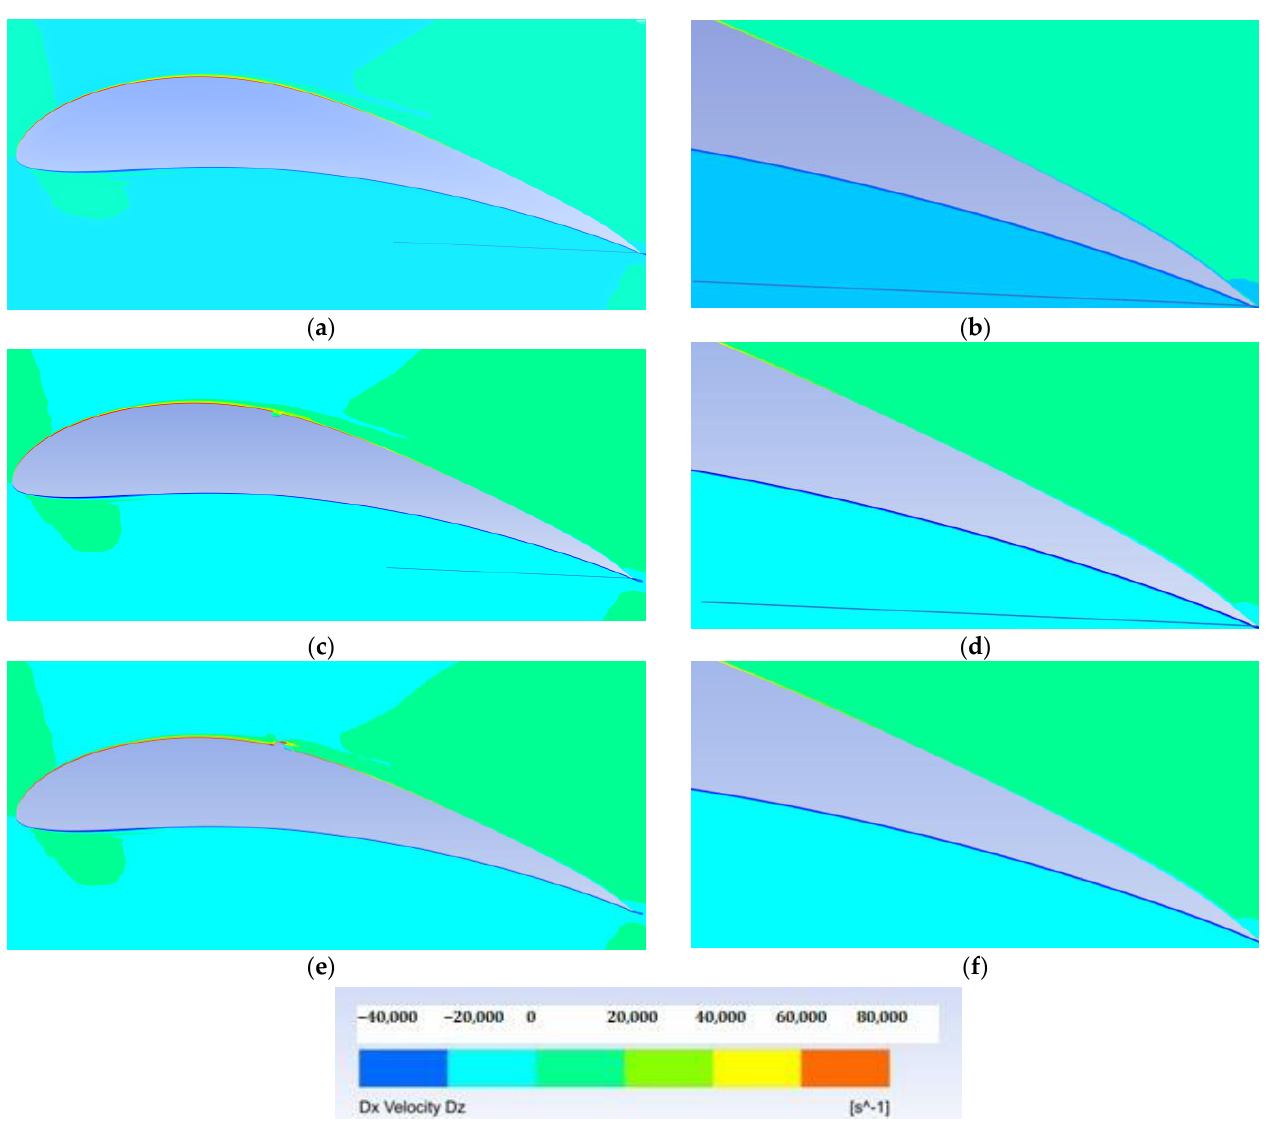
Figure 15. Velocity gradient perpendicular to the airflow axis at an airfoil at 25% of the wingspan, at 8° AoA and Re = 258,000, of the ( a ) original wing, ( b ) zoom-in at the trailing edge of the original wing, ( c ) wing with dimples, ( d ) zoom-in at the trailing edge of the wing with dimples, ( e ) wing with bumps, and ( f ) zoom-in at the trailing edge of the wing with bumps.